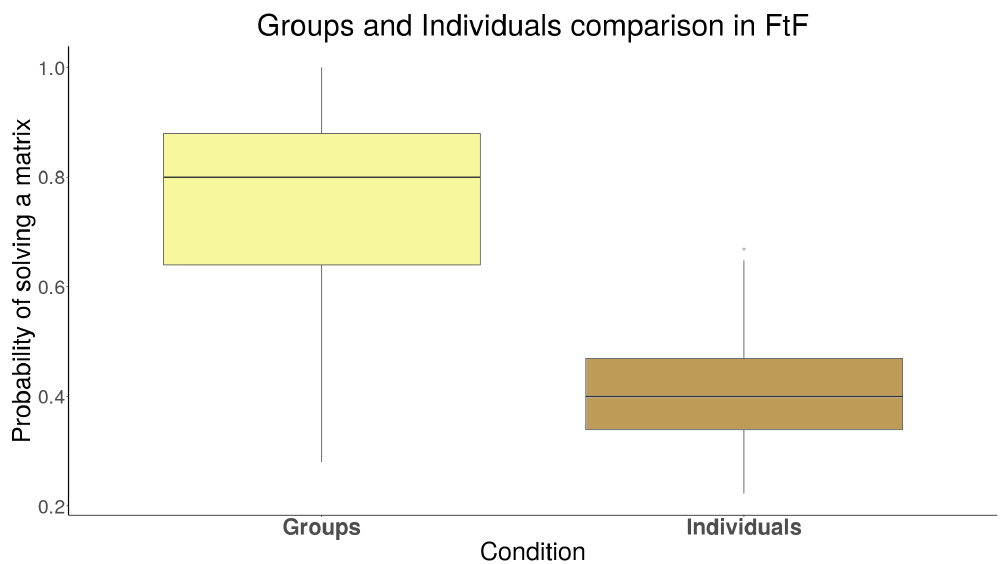
Figure 4. Comparison between individuals’ and FtF groups’ performance. A box-plot is shown, comparing the performance in Raven’s Advanced Progressive Matrices (RAPM) of the groups involved in face-to-face condition (FtF) and the score obtained in the test by teammates when they worked individually (teammates’ average RAPM score). The horizontal lines in the box indicates the median values, respectively Med = 0.8 for groups and Med = 0.4 for